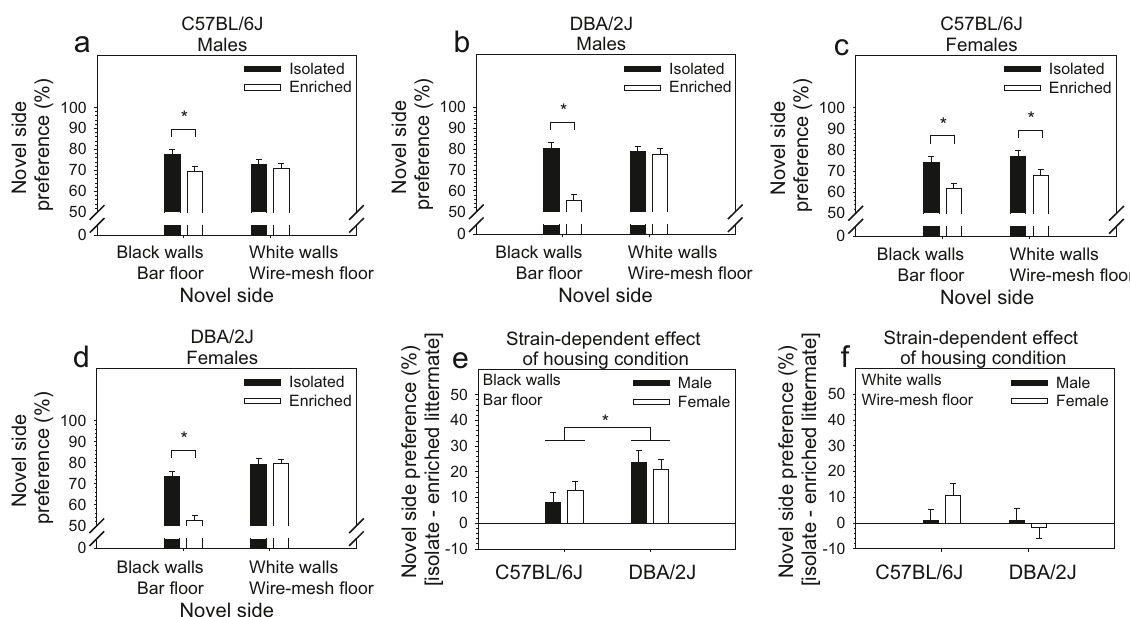
Figure 2. Environmental enrichment reduced novelty preference in a three-chambered place-preference apparatus significantly more in DBA/2J mice relative to C57BL/6J mice. ( a , b , c , d ) Environmentally enriched mice preferred the novel side significantly less than isolated mice; this relationship was true for both C57BL/6J and DBA/2J strains and for males and females within these strains ( p < .05 for all comparisons). However, this relationship was strongly dependent on the characteristics of the novel side (i.e., white walls with a wire-mesh floor or black walls with a bar floor). Specifically, apart from C57BL/6J females, enrichment-induced reduction in novelty preference was exclusively observed when the novel side consisted of black walls with a bar floor. ( e , f ) Reduction in novel side preference following environmental enrichment was significantly greater in DBA/2J mice ( p < .01), but only when the novel side consisted of black walls with a bar